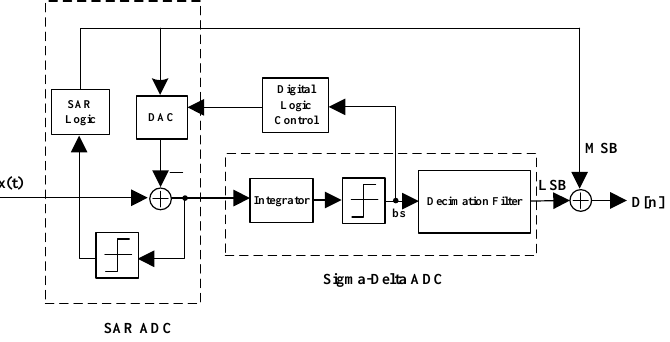
Figure 5. Structure of the zoom ADC. (Note: SAR: successive approximation; LSB: least significant bit; MSB: most significant bit; DAC: digital-to-analog converter).